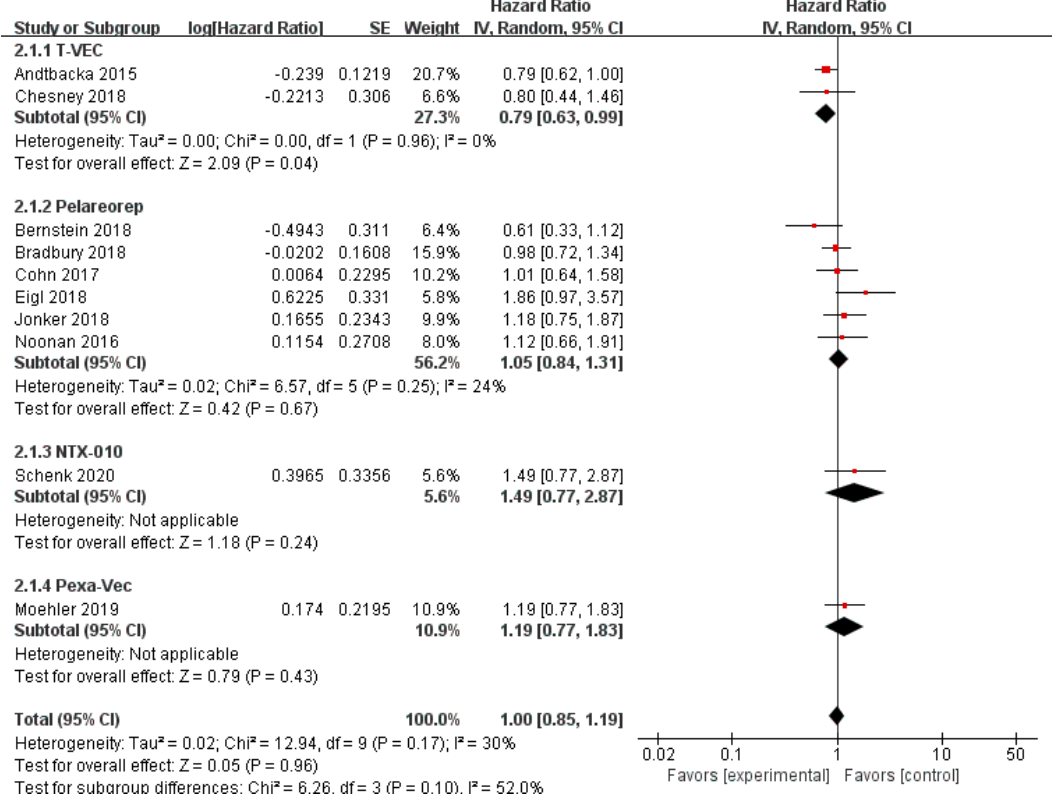
Figure 6. Forest plot of the pooled hazard ratios (HR) for overall survival (OS).